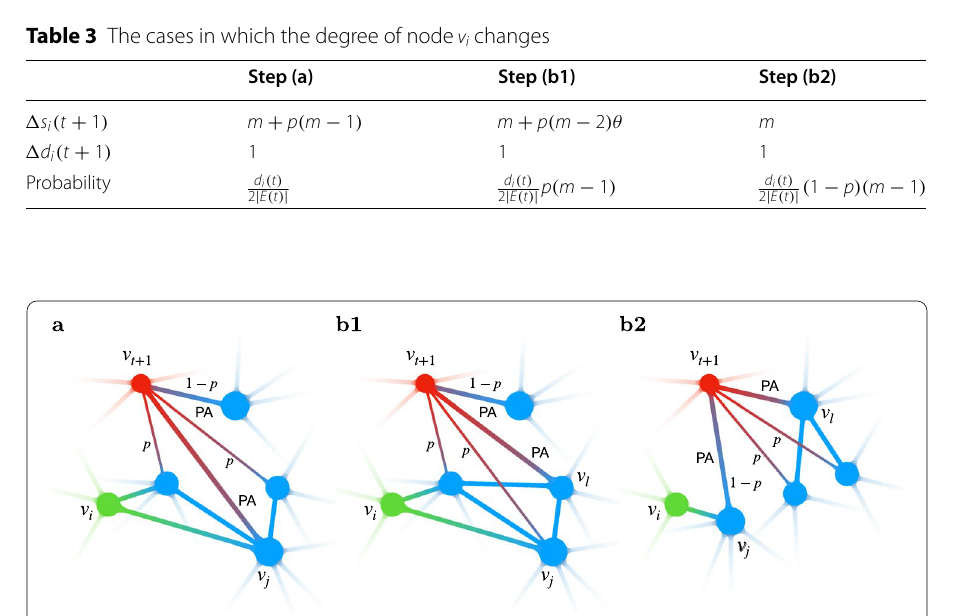
Fig. 12 The cases in which the degree of node v i remains the same but the degree of its neighbors may change at iteration v t + 1 in the triadic closure model. PA means that the link is attached using the preferential attachment (PA)